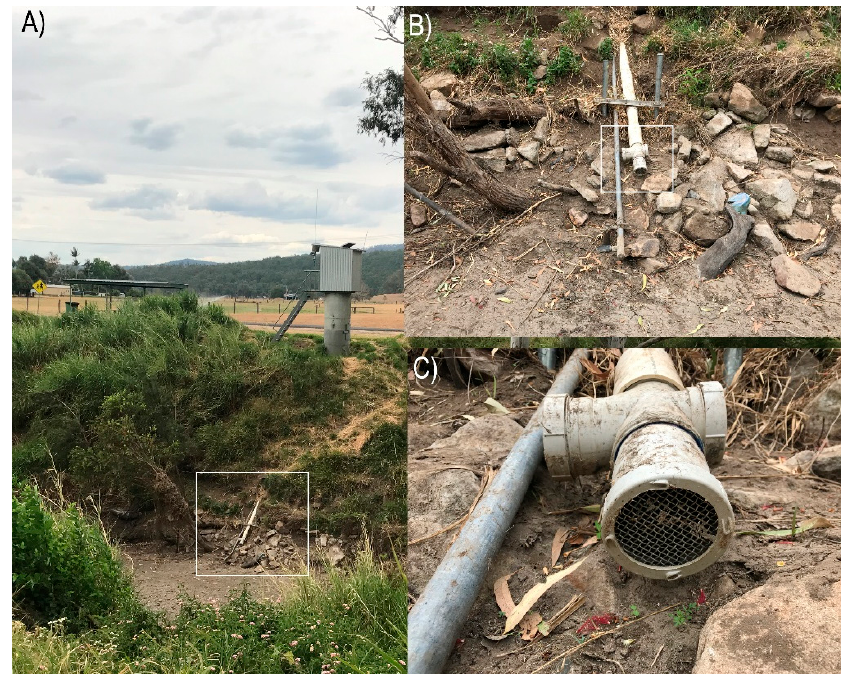
Figure 1. Typical arrangement for current event monitoring stations in the South East Queensland network: ( A ) Monitoring equipment housed in a large infrastructure facility located above a streambank; ( B ) Inset showing the location of a pump inlet for water collection; ( C ) Inset showing the protective cover of the pump inlet relative to the stream bed. The pump inlet has an additional screen (500 µm) within this cover.